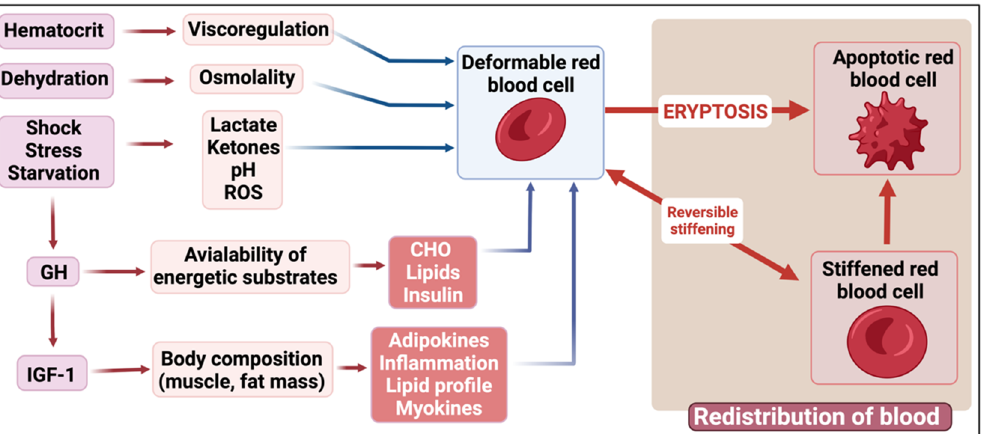
Figure 4. Regulatory loops involved in the modulation of red cell deformability. According to the physiological or pathological context, the factors thoroughly enumerated in this review increase or decrease red cell deformability, thus contributing to the adaptation of microcirculatory blood flow to this context. Erythrocyte stiffening may be a reversible event or one of the components of the cascade of events leading to programmed red cell death (eryptosis). Figure created using www.biorender.com.